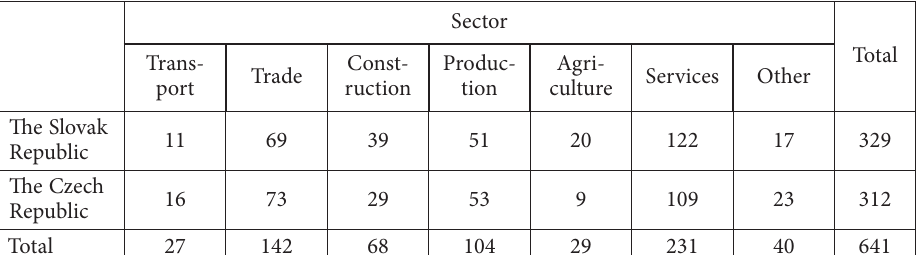
Table 1. Sectorial distribution of companies